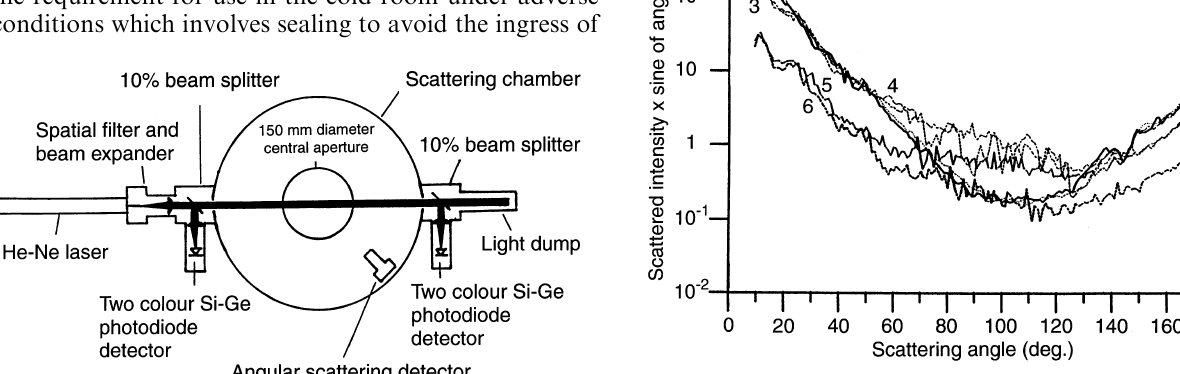
Fig. 3. The e(cid:128)ect on the scattering of the life cycle of the ice crystal cloud in